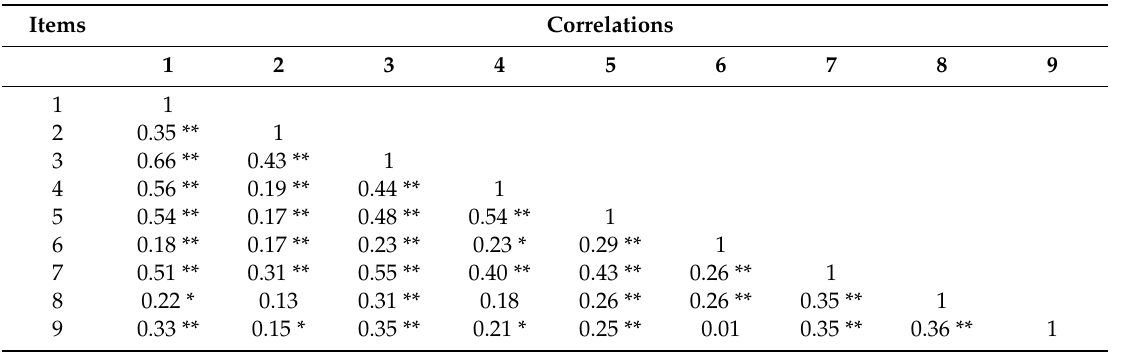
Table 6. Nature questionnaire item